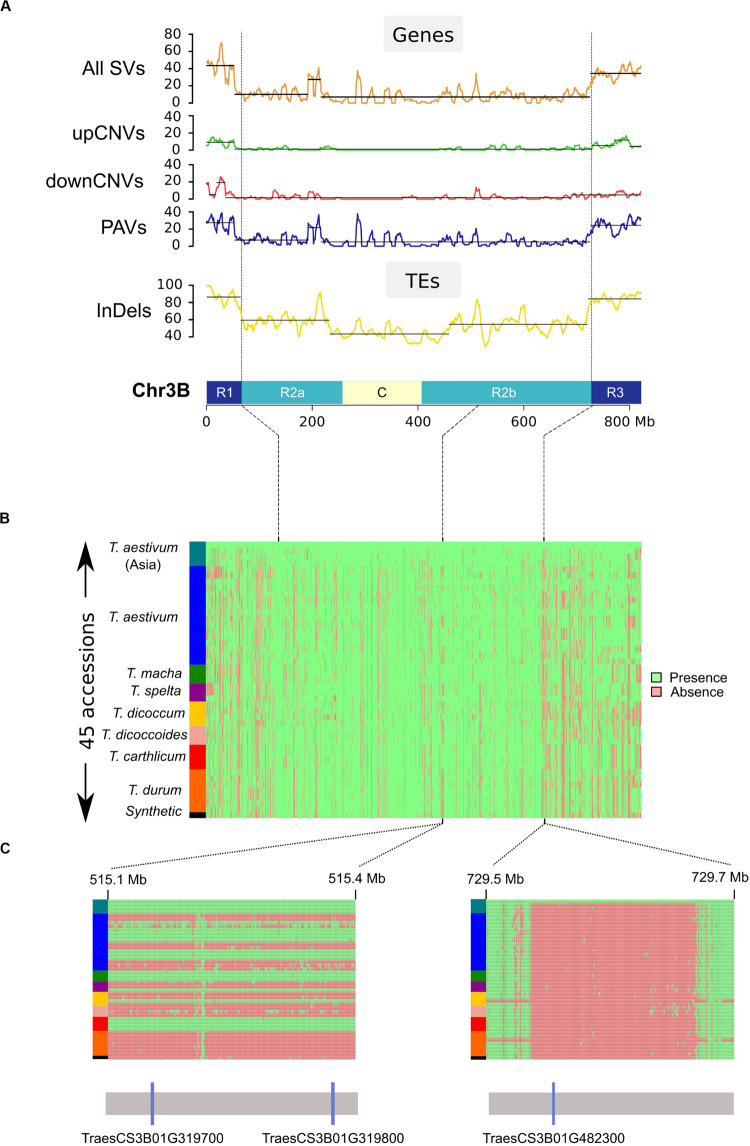
Distribution of structural variations across chromosome 3B. (A) Distribution of SVs affecting genes and TEs calculated in a sliding window of 10 Mb (step = 1 Mb). Chromosome 3B is represented at the bottom of the graphs with distal (R1 and R3), interstitial (R2a and R2b), and centromeric/pericentromeric (C) regions. (B) PAV matrix of the 1,593,66 studied loci across chr3B for the 45 accessions (1 line per accession). Accessions were ordered according to their phylogenetic relationships (see “Phylogenetic analysis”). Presence and absence are shown in green and red, respectively. (C) Zoom in view for two regions: the left region carries a pair of duplicated genes (TraesCS3B01G319700 and TraesCS3B01G319800) that are either fully absent or present in our panel. The right region carries gene TraesCS3B01G482300 present only in Chinese Spring.